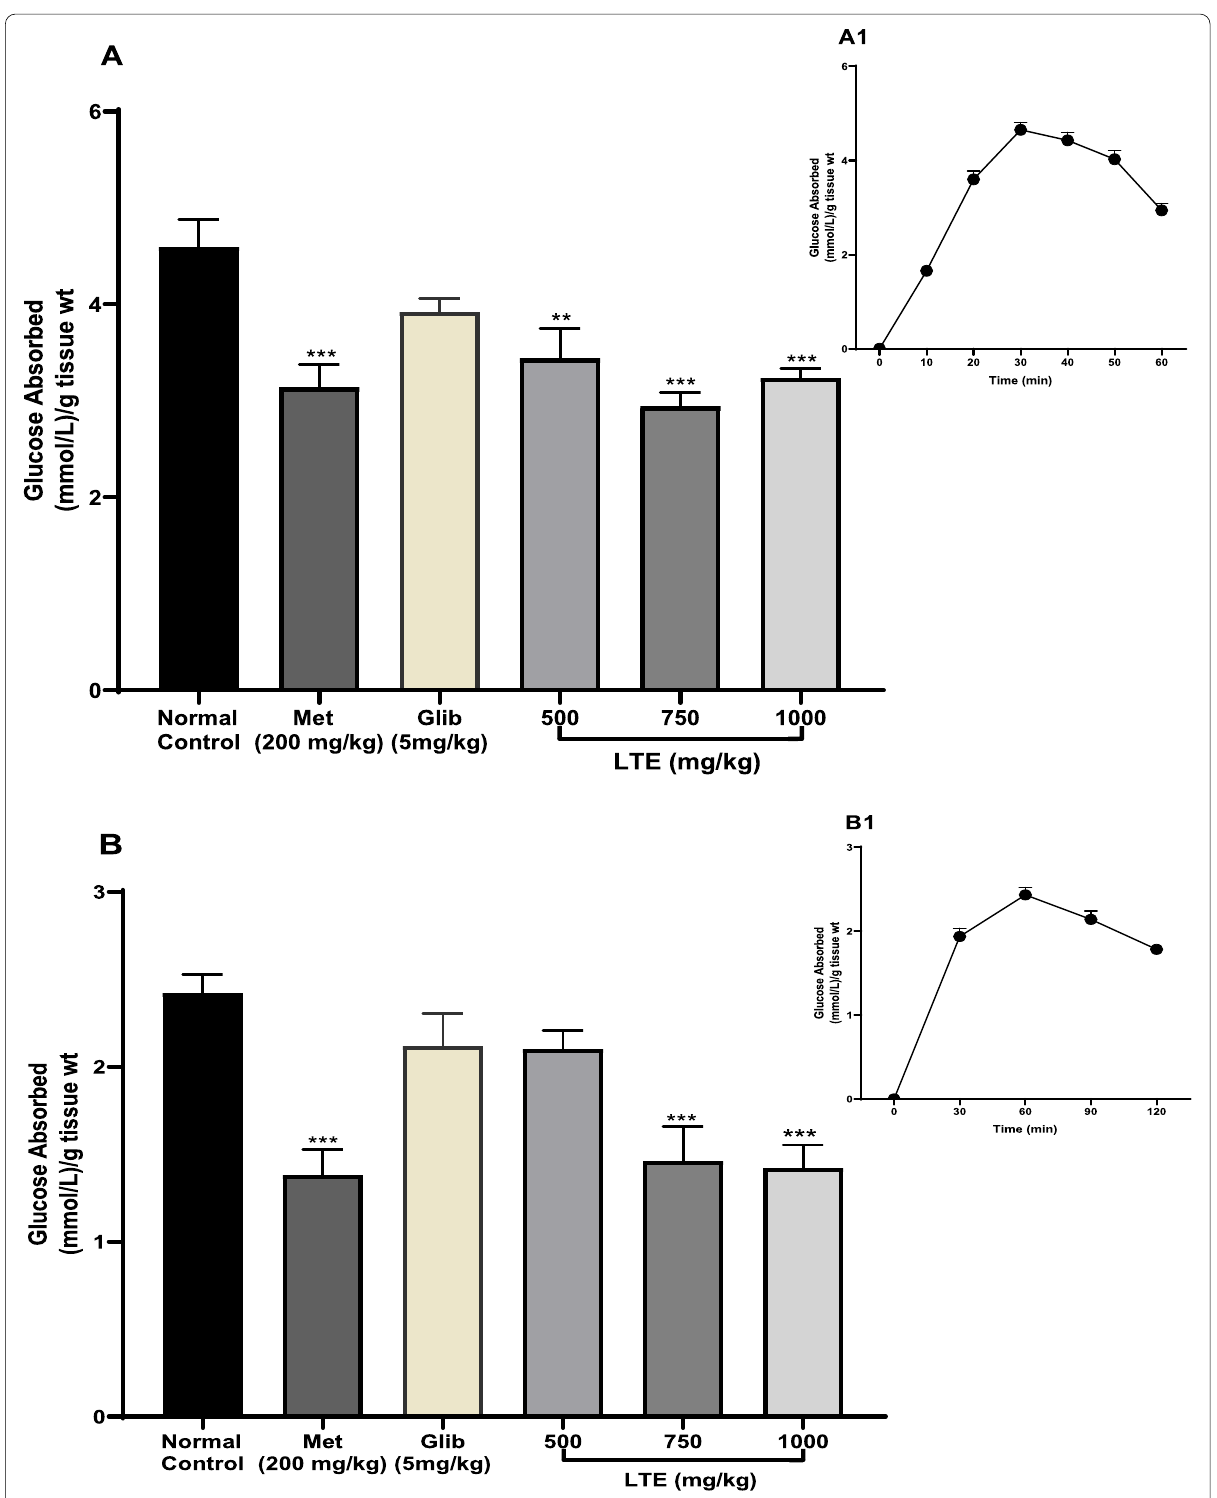
Fig. 9 Effects of LTE on (in‑vivo) intestinal glucose absorption ( A ) with time‑course insert, 9A1. Figure 9 B shows glucose absorption by intestinal sacs with a time‑course insert, 9B1. Values were expressed as mean multiple comparisons test. * represents statistical significance at p < 0.05 vs. the normal control